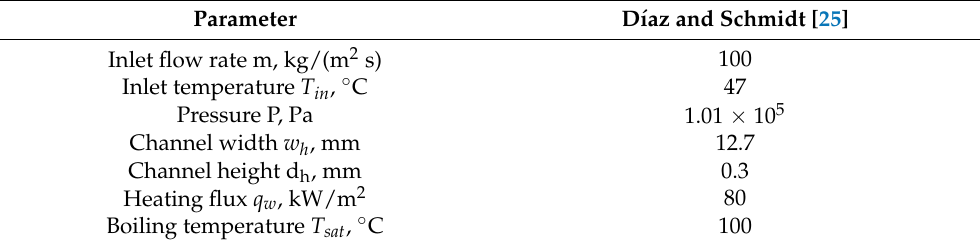
Table 3. Input data for the 2D model of the heat transfer of boiling water in a microchannel.